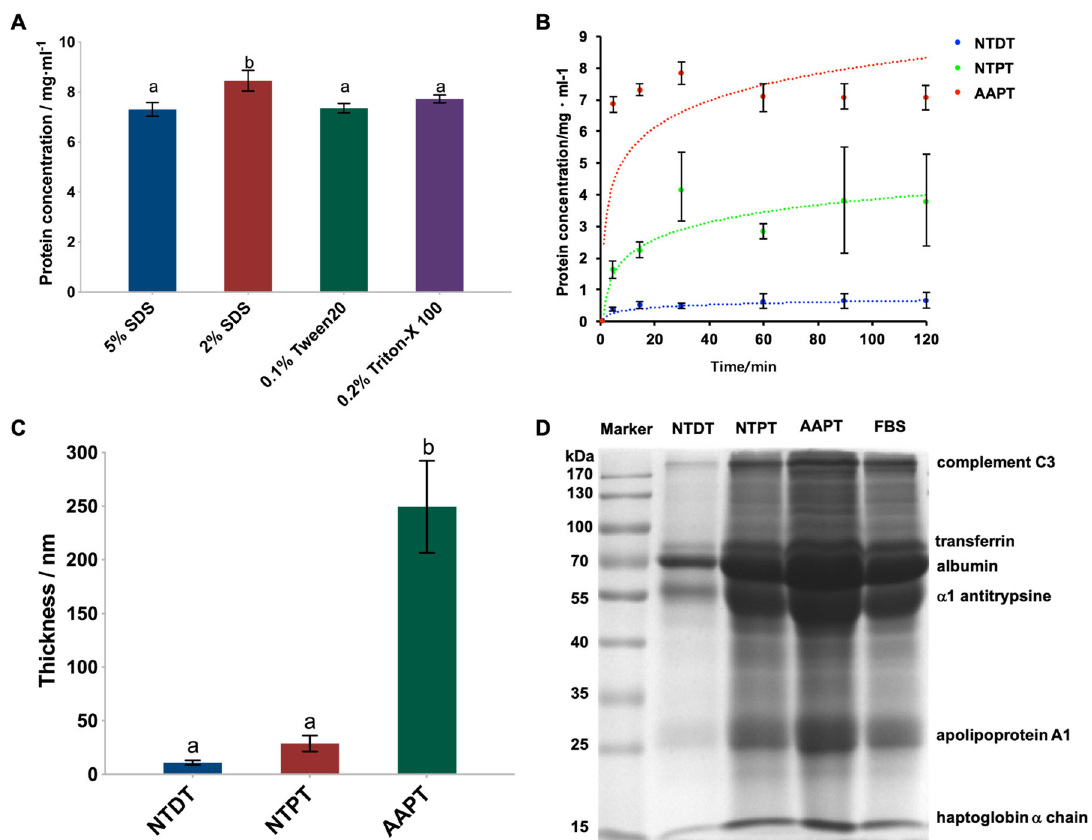
Fig. 2 Serum protein adsorption of Ti with or without surface treat- ment. A Detached protein concentration obtained with different sur- factants. The results showed that 2% SDS was most ef fi cient among the applied solvents and was used to elute the adsorbed proteins in the following experiments ( n = 4). B The adsorbed protein amount in each group at each time point was quantitatively analyzed by the BCA method ( n = 4). The results showed that AAPT adsorbed more serum